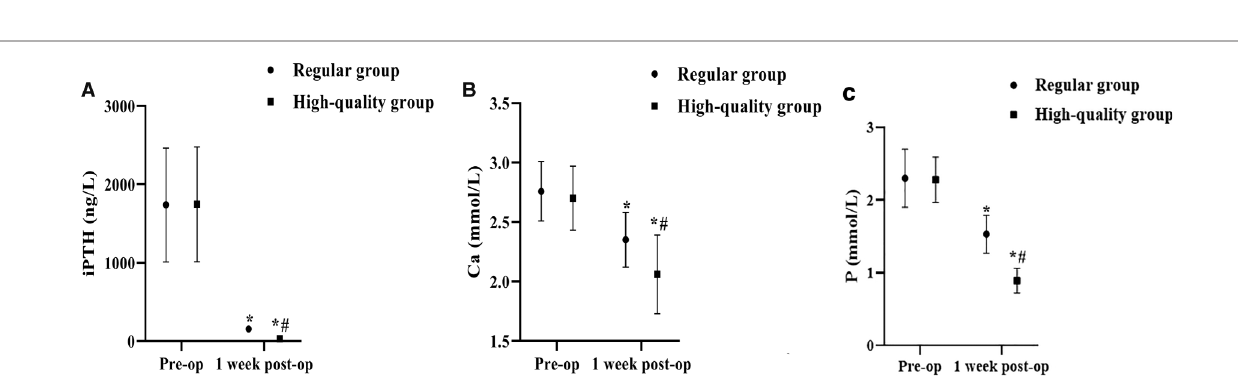
FIGURE 4 | Comparison of iPTH, Ca, and P levels between the two groups before and 1 week after surgery. (Mean, SD). Note: ( A ) shows iPTH levels, ( B ) shows Ca levels, and ( C ) shows P levels. * shows the difference with the same group before care, p <0.05; # shows the difference with the Regular group, p <0.05.